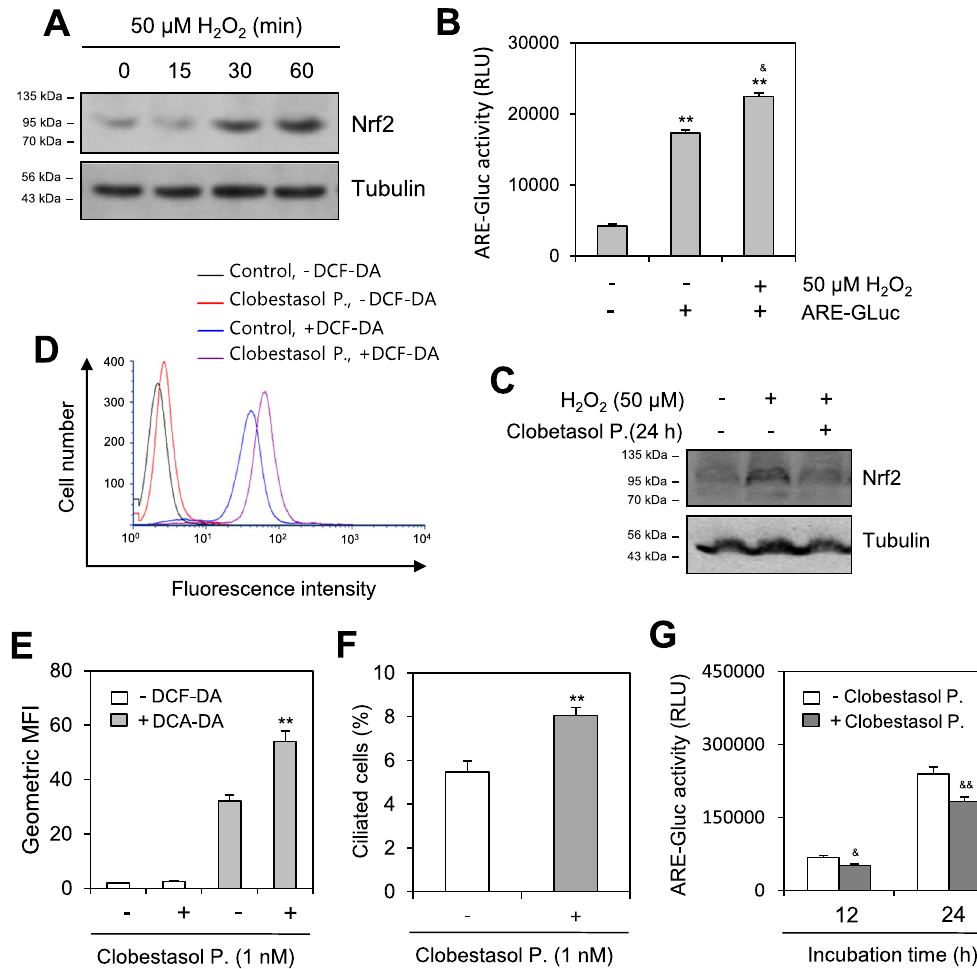
Figure 4. Effect of H 2 O 2 and Nrf2 on primary cilia formation. ( A ) Cells were treated with 50 μM H 2 O 2 for 15, 30 and 60 min. Cell lysates were prepared from each sample and Nrf2 proteins were detected by western blotting. ( B ) HeLa cells were transfected with antioxidant response element (ARE)-Gaussia luciferase (Gluc) plasmid DNA and incubated in the absence or presence of 50 μM H 2 O 2 . ARE-Gluc activity in cultured media was measured with luminometer using Gluc substrate. ( C ) Cells were treated with 50 μM H 2 O 2 in the absence or presence of clobestasol propionate (P.). Cell lysates were prepared from each sample and Nrf2 proteins were detected by western blotting. ( D – F ) Cells were incubated in the absence or presence of clobestasol P under SD condition. Cells were treated with DCF-DA and ROS production was measured by FACS analysis ( D ). Geometric mean fluorescence intensity (MFI) in the absence (white) or presence (grey) of clobestasol P. was analyzed by WinMDI 2.8 for each sample ( E ). The cells were fixed and stained with antibody against Ac-tubulin. The number of ciliated HeLa cells out of more than 1000 cells in the absence (white) or presence (grey) of clobestasol P. were counted. PC frequency was evaluated by the blinded double scoring ( F ). ( G ) HeLa cells were transfected with pEZX-PG02-TB4-promoter Gaussia luciferase (Gluc) plasmid and incubated with SD condition in the absence (white) or presence (grey) of clobestasol P. for up to 24 h. The activity of Gluc in cultured media was measured with luminometer using Gluc substrate. Each result was the representative of experiments performed at least four times and each experiment was performed with four samples (n = 4) in the same group. Processing (such as changing brightness and contrast) is applied equally to controls across the entire image. Original images of full-length blots were included in the Supplementary Information file ( A , C ). Data in bar graphs represents the means ± SD ( B , E – G ). ** p < 0.01; significantly different from H 2 O 2 -untreated and ARE-untransfected group ( B ) or SD-treated and clobestasol P.-untreated group ( E , F ). & p < 0.05, && p < 0.01; significantly different from H 2 O 2 -untreated and ARE-transfected group ( B ) or clobestasol P.-untreated group ( G